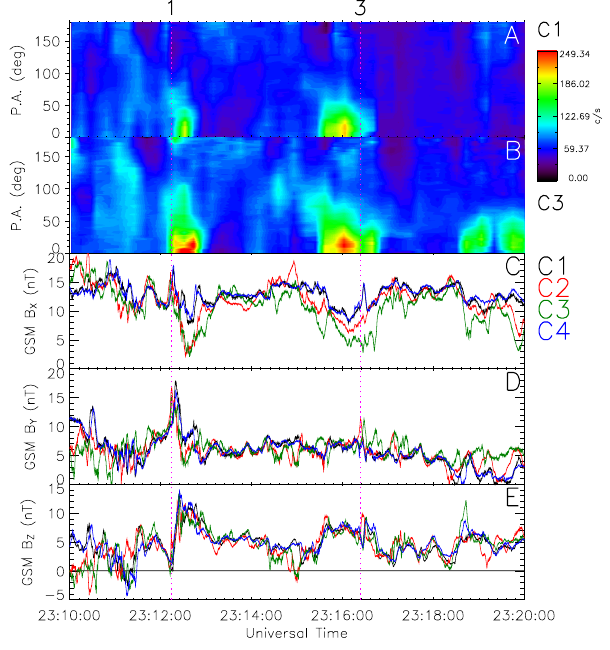
Fig. 3. Panels (A) and (B) show pitch angle-time spectrograms for HIA on board C1 and C3, respectively, and panels (C–E) GSM components of the magnetic field for all 4 Cluster spacecraft (colors as before). Signatures 1 and 3 are marked by magenta dotted